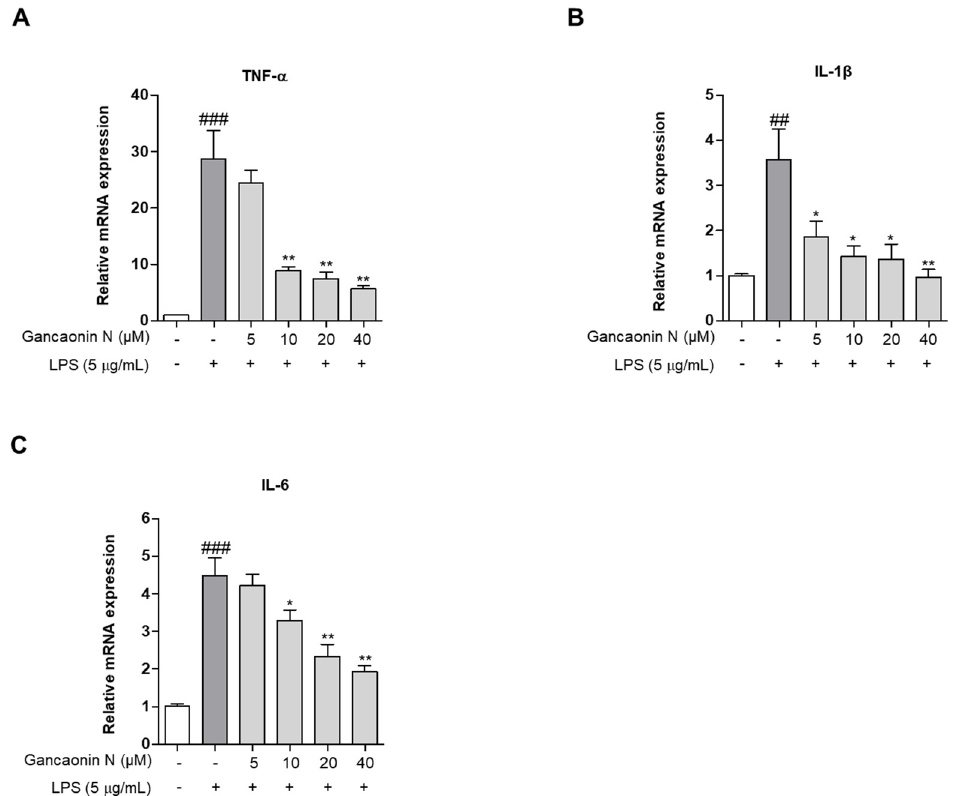
Figure 3. ( A – C ) Effects of Gancaonin N on pro-inflammatory cytokine mRNA expression in LPS-induced A549 cells. Gancaonin N (5–40 µ M) was pretreated 2 h prior to LPS-induced inflammation in A549 cells, incubated for 24 h with LPS (5 µ g/mL). The mRNA expressions of cytokine were investigated by real-time PCR analysis. Values are represented as means ± SEM. ## p < 0.01, ### p < 0.001 are significantly different from non-treated group; * p < 0.05, ** p < 0.01 are significantly different from only LPS-treated